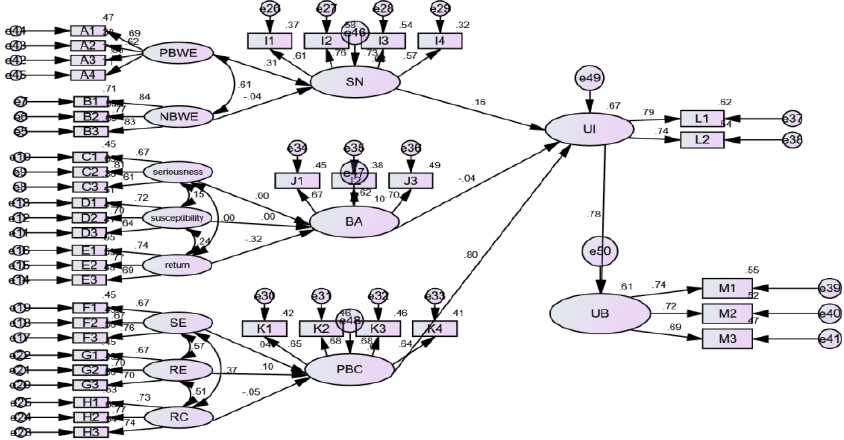
Figure 2. Structural model of the green utilization factors of agricultural waste. Notes: PBWE: positive broken window effect; NBWE: negative broken window effect; SE: self-efficacy; RE: response efficacy; RC: response cost; SN: subjective norms; BA: behavioral attitude; PBC: perceived behavioral control; UI: utilization intention; UB: utilization behavior.